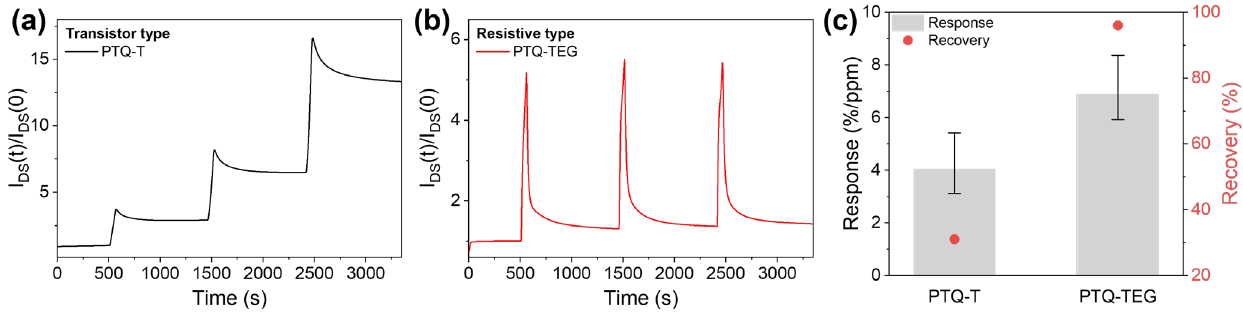
Figure 6. NO 2 detection characteristics of ( a ) PTQ-T and ( b ) PTQ-TEG and comparison of their sensitivity and recovery tendency. ( c ) indicates the NO 2 detectivity and recovery tendency of each CP.